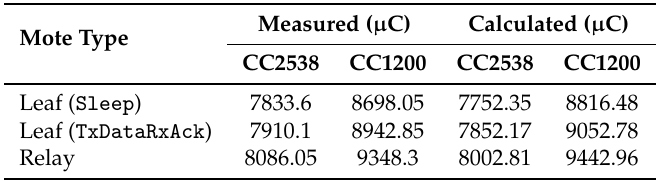
Table 17. Measured and calculated charge drawn during a slot frame.